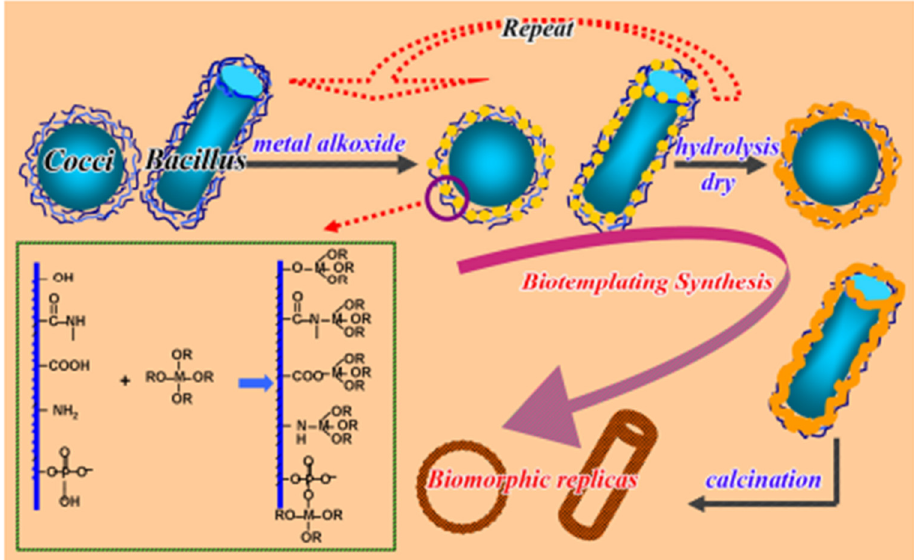
Figure 16. Schematic illustration of the biotemplating synthesis of biomorphic hollow structures via the surface sol-gel process. Reprinted with permission from [54].